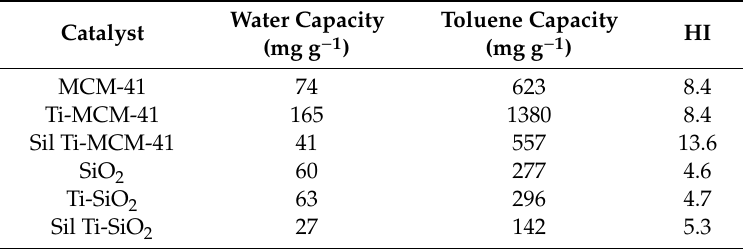
Table 7. Competitive water / toluene adsorption capacity and Hydrophobic Index. Adapted from Reference